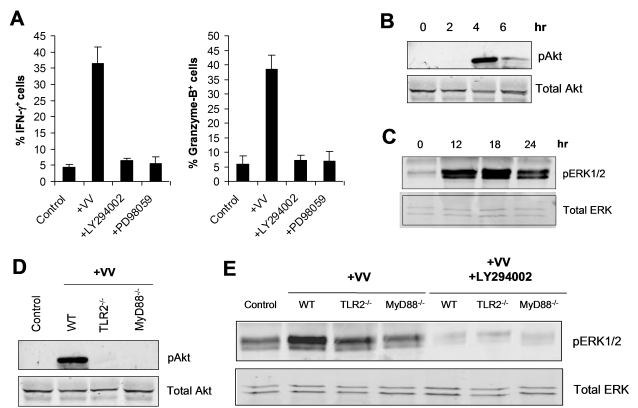
TLR2-dependent activation of NK cells by VV is mediated by PI3K and ERK.(A) DX5+CD3− NK cells were infected with VV (+VV), VV in the presence of the PI3K inhibitor, LY294002 (+LY294002) or the ERK inhibitor, PD98059 (+PD98059) in vitro. 48 h after infection, NK cells were assayed for intracellular IFN-γ and Granzyme B. The mean percentage ± SD of IFN-γ or Granzyme B positive cells among DX5+CD3− cells is shown. Data shown is representative of three independent experiments. (B–C) DX5+CD3− NK cells were stimulated in vitro with VV for the indicated time periods. After stimulation for 2, 4, and 6 h, NK cells were removed from culture and total cell lysates were collected for Western blot analysis of phosphorylated Akt (pAkt) as well as total Akt (Total Akt), which served as a loading control (B). After stimulation for 12, 18, and 24 h, NK cells were removed from culture and total cell lysates were collected for Western blot analysis of phosphorylated ERK1/2 (pERK1/2) as well as total ERK (Total ERK) (C). (D) WT, TLR2−/−, and MyD88−/− DX5+CD3− NK cells were stimulated in vitro with VV (+VV), or left unstimulated (Control) for 4 h. NK cells were removed from culture and total cell lysates were collected for Western blot analysis of phosphorylated Akt (pAkt) as well as total Akt (Total Akt). (E) WT, TLR2−/−, and MyD88−/− DX5+CD3− NK cells were stimulated in vitro with VV (+VV), VV and the PI3K inhibitor LY294002 (+LY294002), or left unstimulated (Control) for 18 h. NK cells were removed from culture and total cell lysates were collected for Western blot analysis of phosphorylated ERK1/2 (pERK1/2) as well as total ERK (Total ERK). Data shown is a representative blot of five independent experiments.